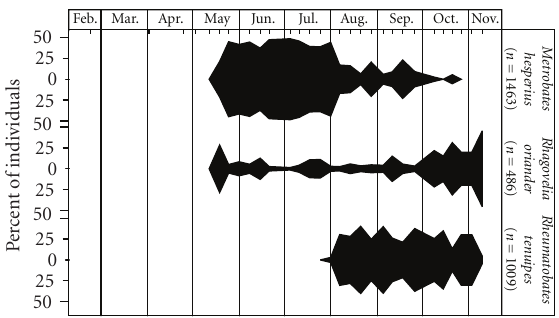
Figure 7: Percent of total individuals of each species ( Metrobates hesperius , Rhagovelia oriander , and Rheumatobates tenuipes ) on each sample date.